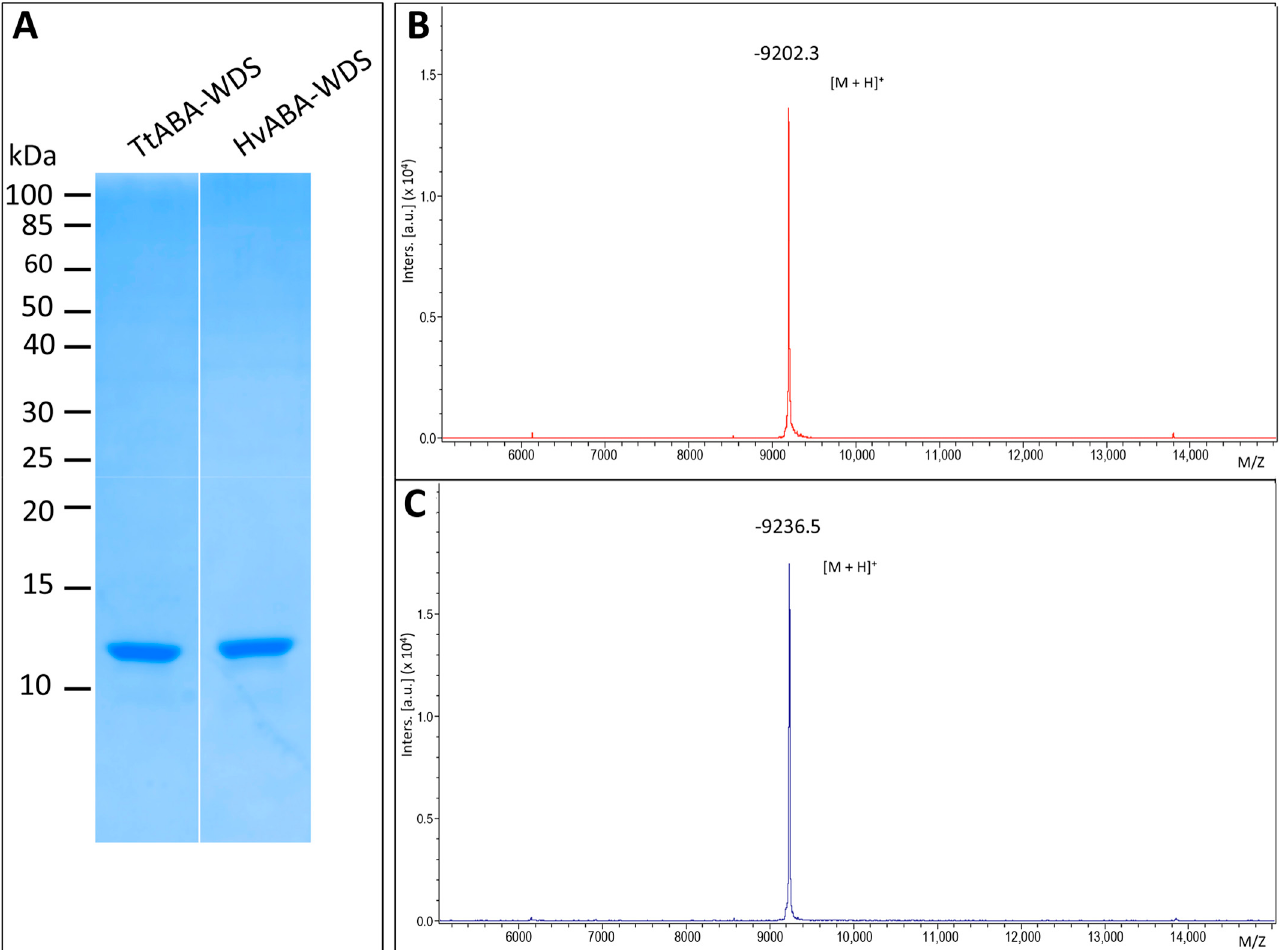
Figure 3. Purification of TtABA-WDS and HvABA-WDS domains from E. coli . ( A ) Coomassie blue staining of an 18% SDS-PAGE analysis showing the purified products as obtained after SEC. ( B , C ) MALDI-TOF-TOF mass analysis of intact TtABA-WDS ( B ) and HvABA-WDS ( C ) proteins. ( B ) Intact TtABA-WDS generated an average mass of 9201.30 Da for a theoretical mass of 9200.12 Da. ( C ) Intact HvABA-WDS generated an average mass of 9235.50 Da for a theoretical mass of 9234.22 Da. Masses were obtained with respectively 128 ppm ( B ) and 140 ppm ( C ) errors compatibles with the resolution of the spectrometer.